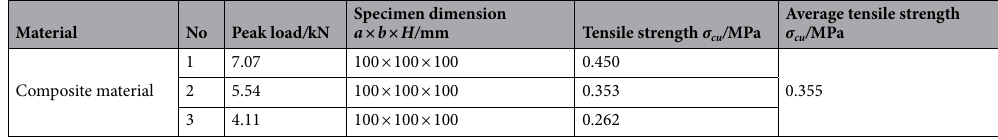
Table 2. Results of Brazilian split testing.